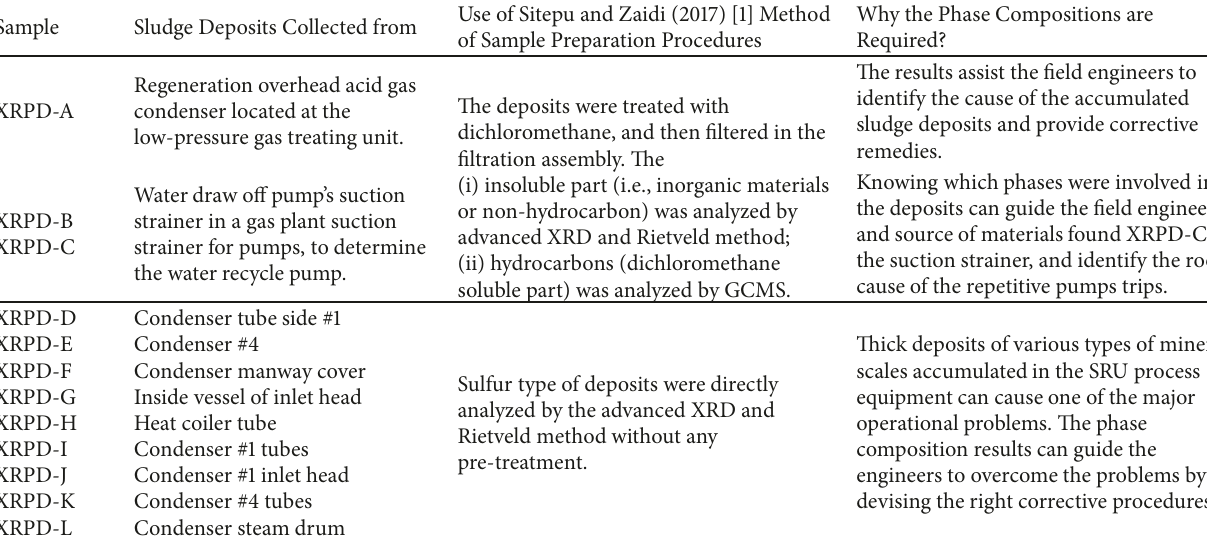
Table 2: The description of the sludge samples investigated in this